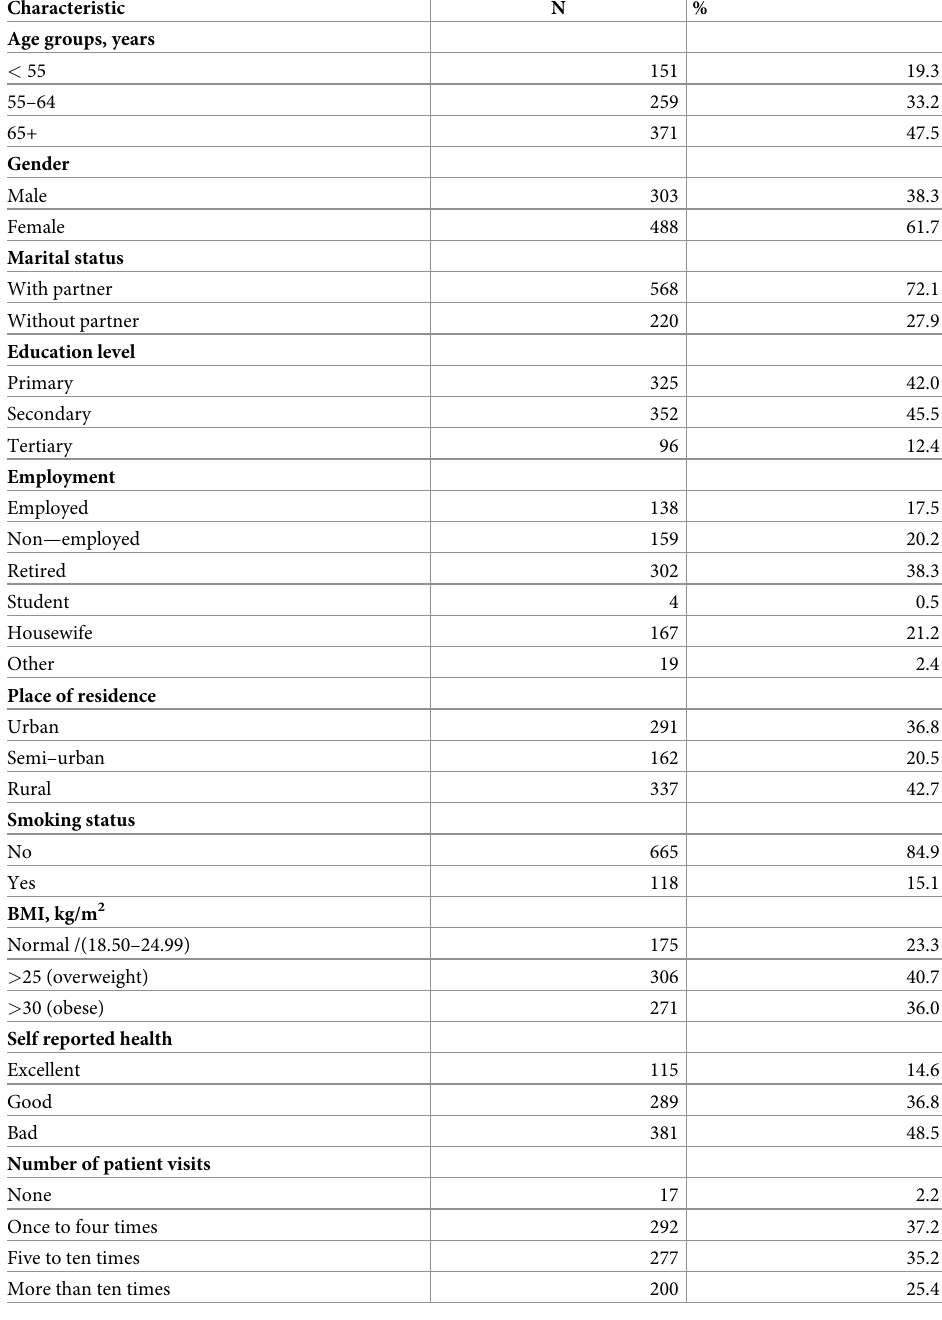
Table 1. Socio-demographic characteristics of